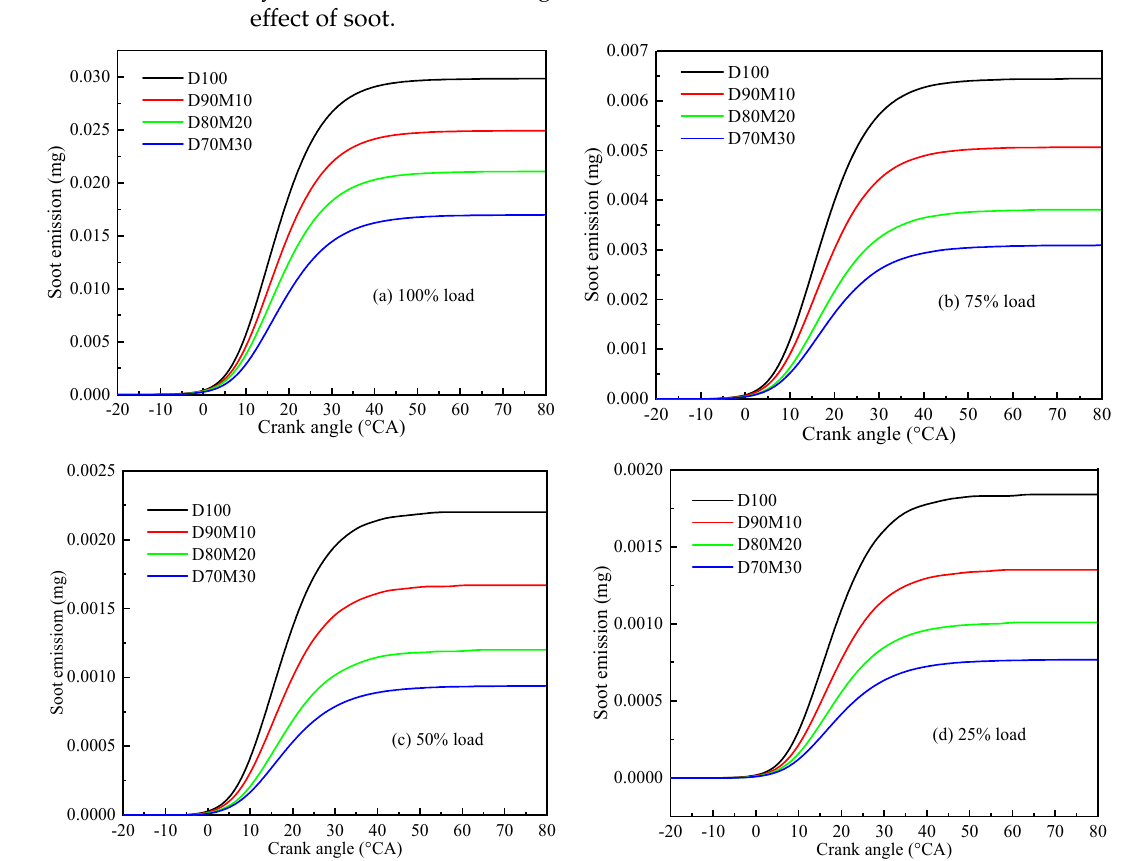
Figure 12. Soot emission curves of different proportions of diesel–methanol blended fuel under different load conditions. ( a ) at 100% load, ( b ) at 75% load, ( c ) at 50% load, ( d ) at 25% load.